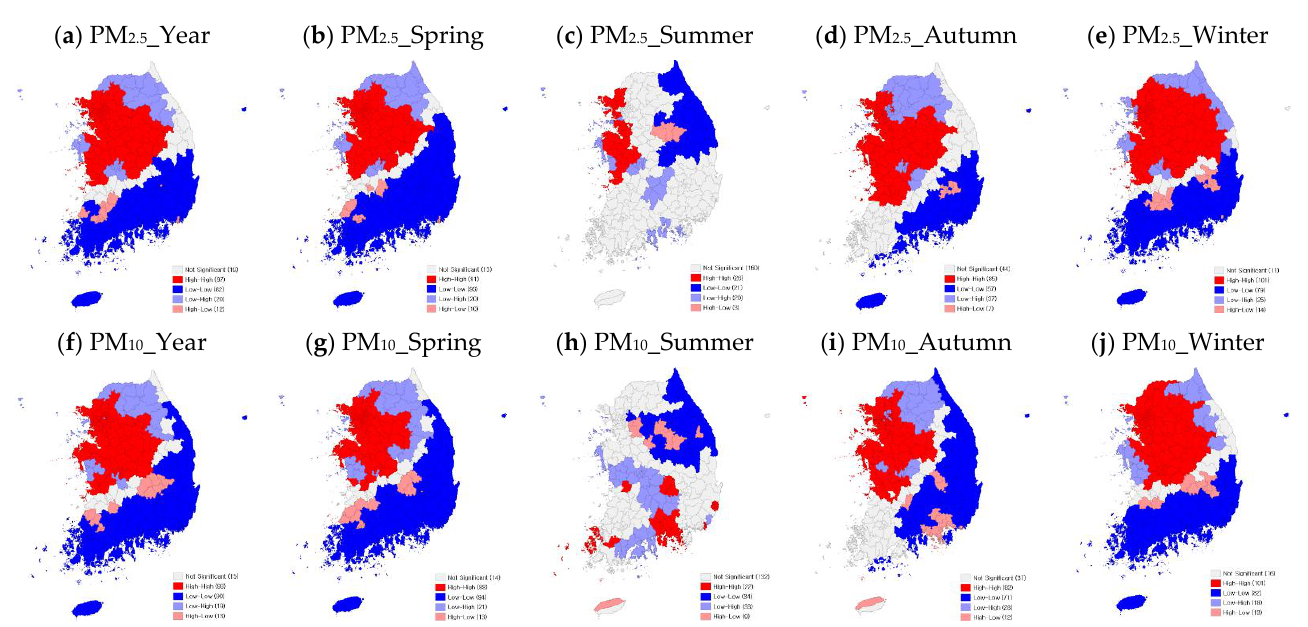
Figure 4. Moran’s I analysis results .